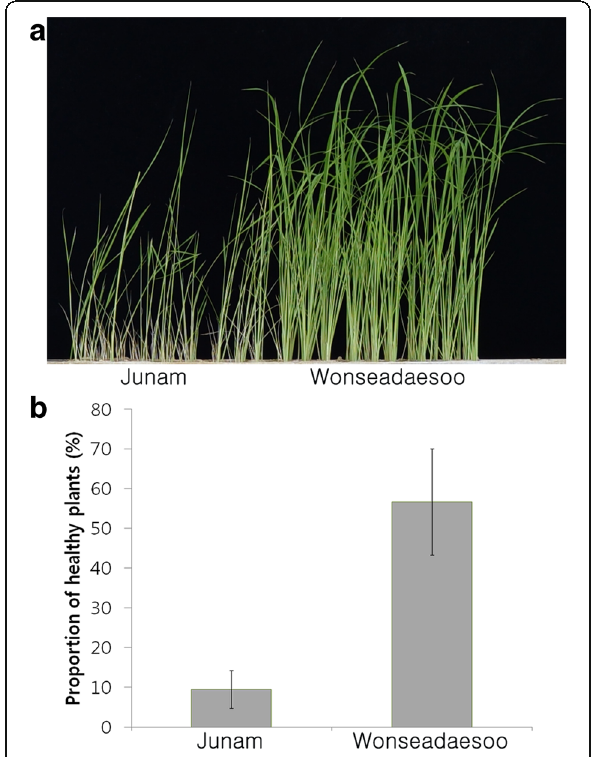
Fig. 1 Phenotype ( a ) and proportion of healthy plants ( b ) in parental varieties infected with the Fusarium fujikuroi isolate